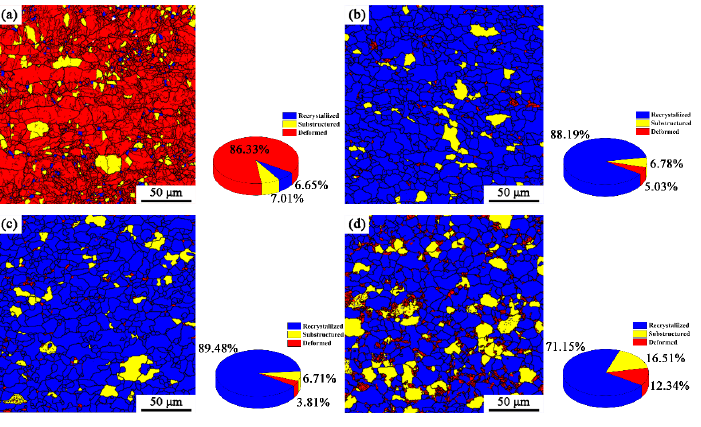
Figure 3. Recrystallization microstructure distribution of X2CrNi12 steel at different annealing tem- peratures with 50% cold-rolling deformation ( a ) deformed; ( b ) 720 °C; ( c ) 740 °C; ( d ) 770 °C.